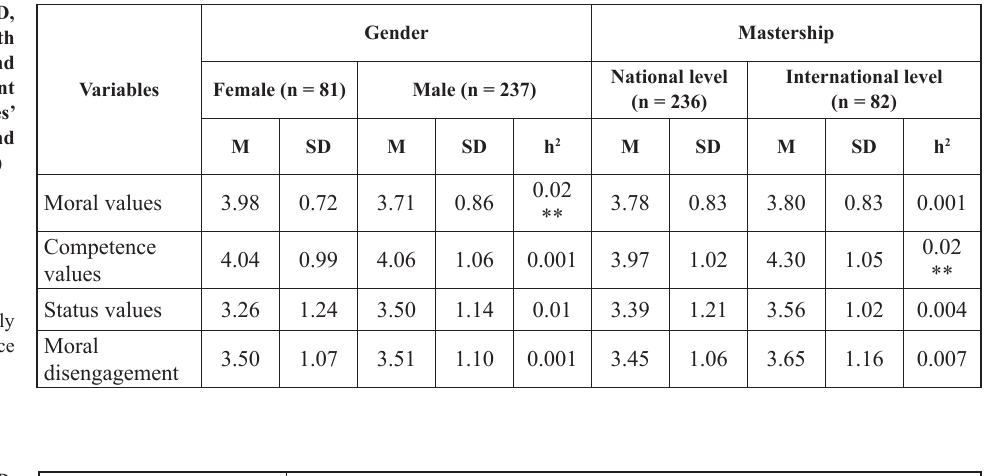
Note. ** – p < 0.01. Alpha coefficients are reported on the diagonal.